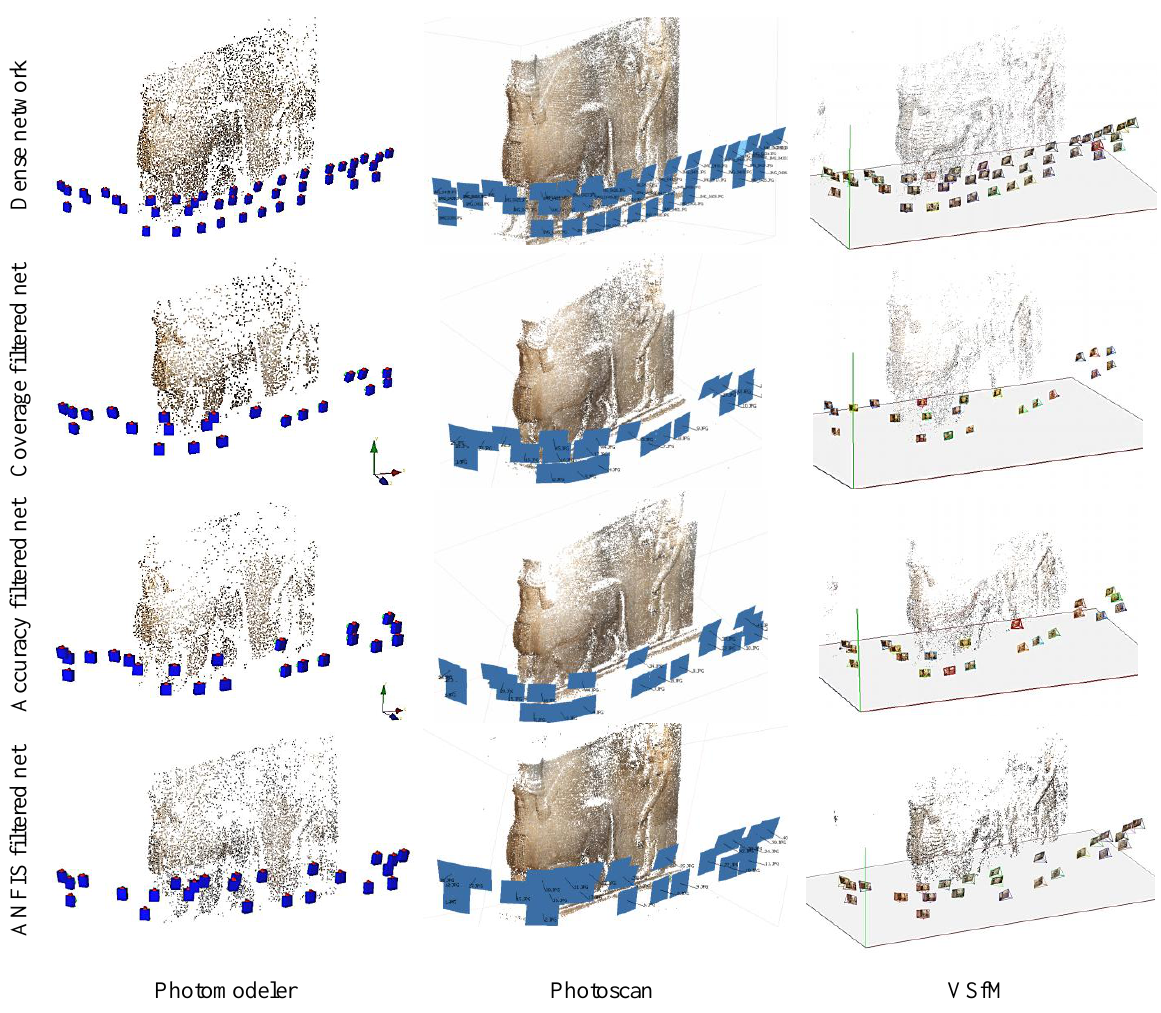
Figure 14. The fully automatic orientation of the four networks with different